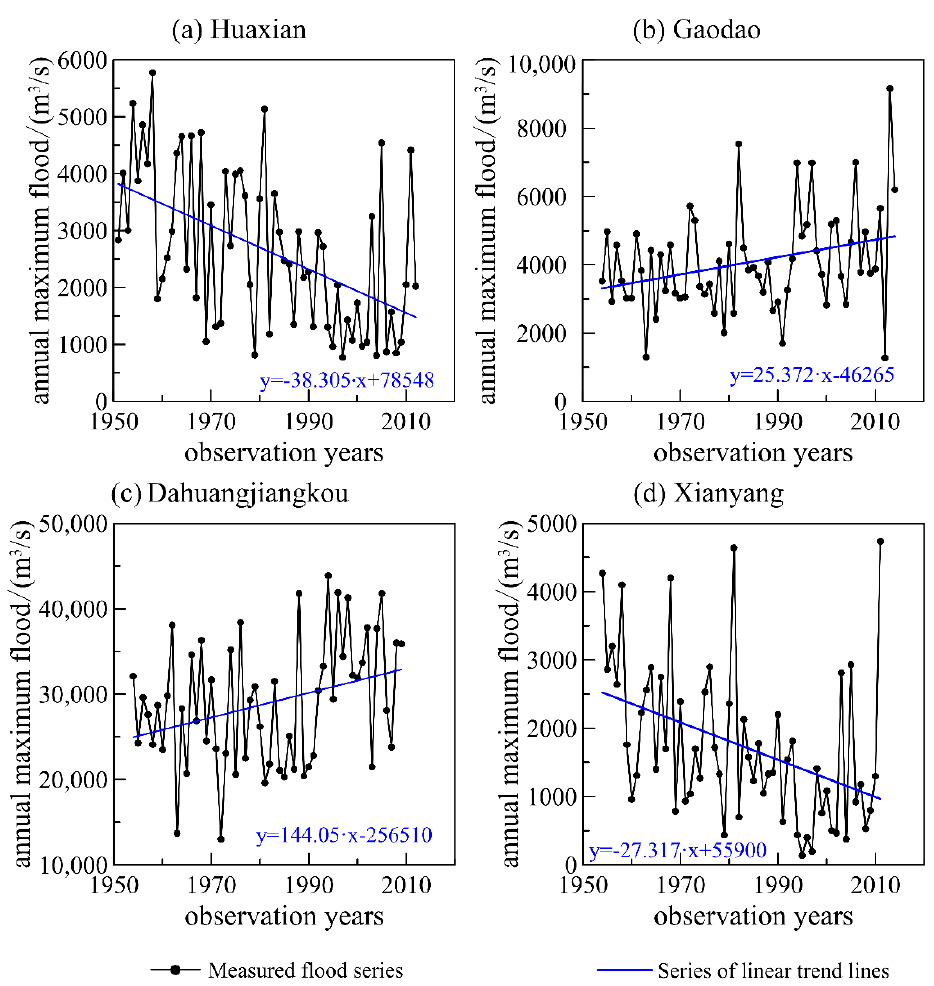
Figure 2. Linear trend line of annual maximum flood series for ( a ) Huaxian station; ( b ) Gaodao station; ( c ) Dahuangjiangkou station; ( d ) Xianyang station.